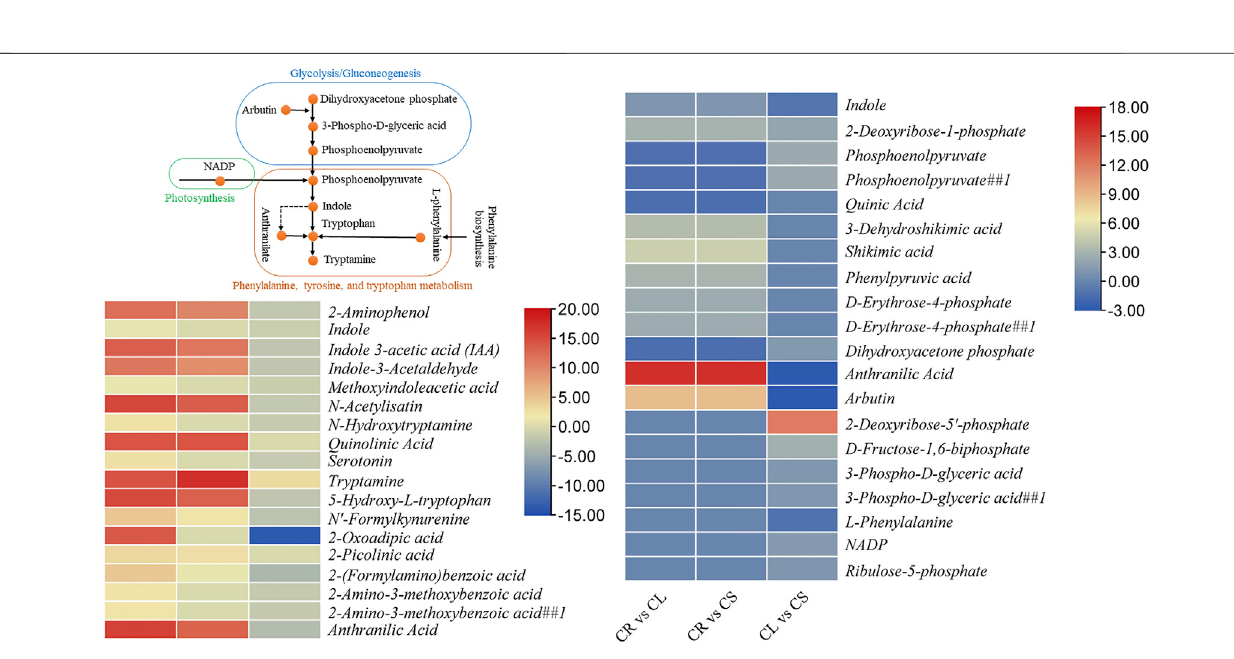
Frontiers in Genetics |